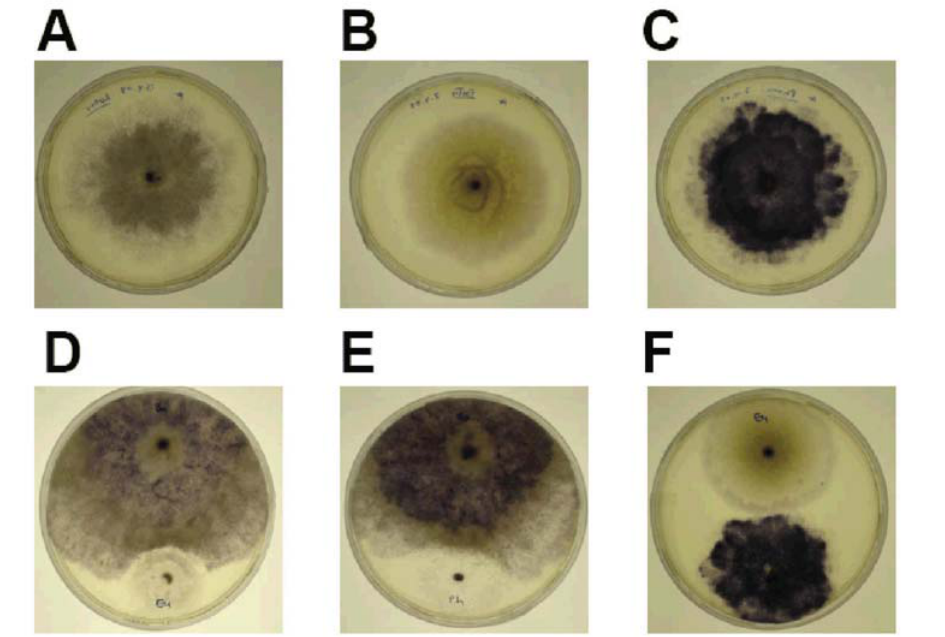
Fig. 3. Superoxide detected with NBT coloration (fungal growth for 4–7 days): (A) Botryosphaeria parva ; (B) Eutypa lata ; (C) Phomopsis viticola ; and interactions between the fungi: (D) B. parva - E. lata ; (E) B. parva - P. viticola ; (F) E. lata - P. viticola